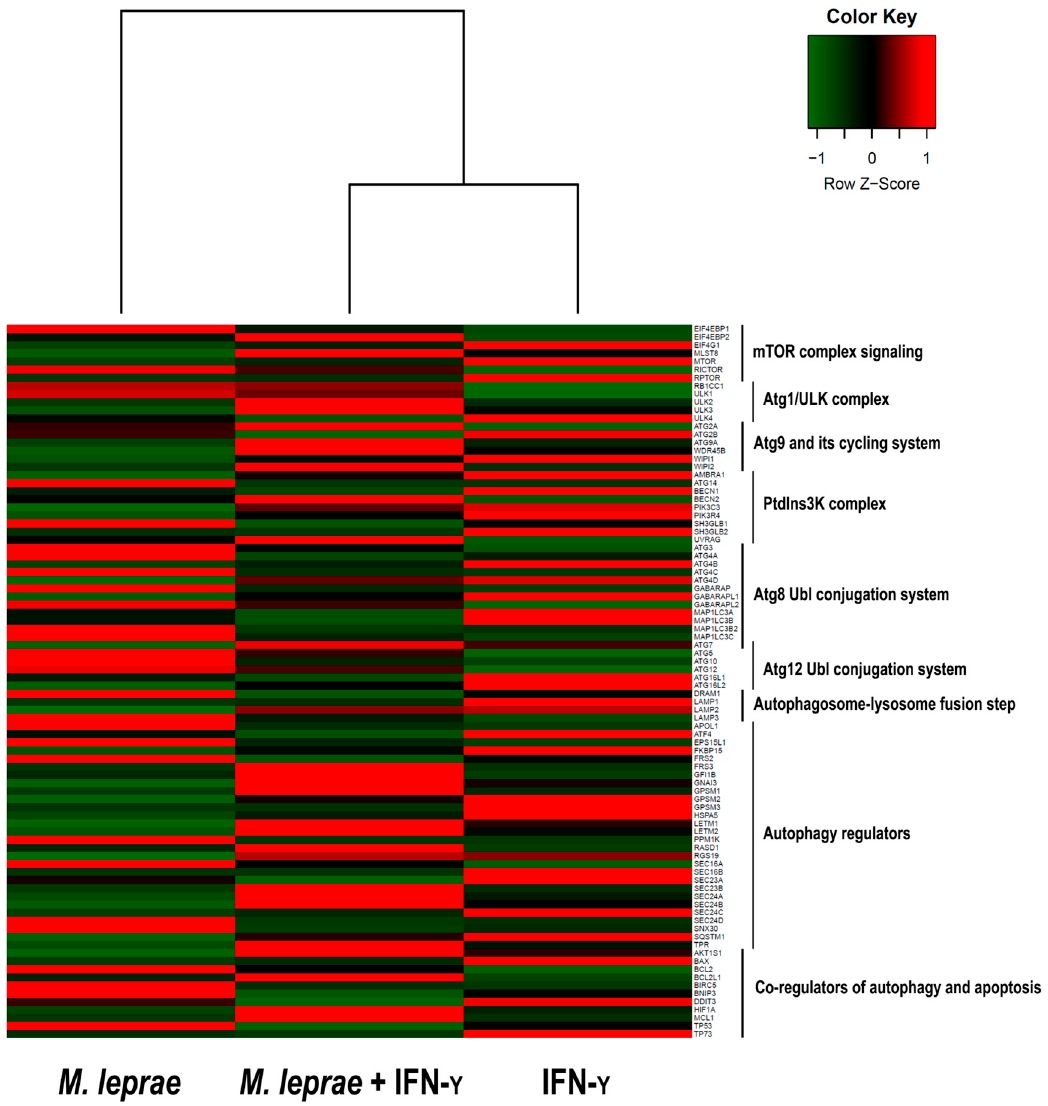
Figure 3. Autophagy gene expression profiles of THP-1 cells stimulated with M. leprae and IFN- γ . mRNAs of THP-1 macrophages treated with M. leprae + IFN- γ , as well as the macrophages treated individually with each stimulus, were analyzed by RT-qPCR using an autophagy pathway array PCR kit. The heatmap shows the analysis of autophagy-related genes aggregated in different categories. Each line is representative of a gene. Data represent three independent experiments.